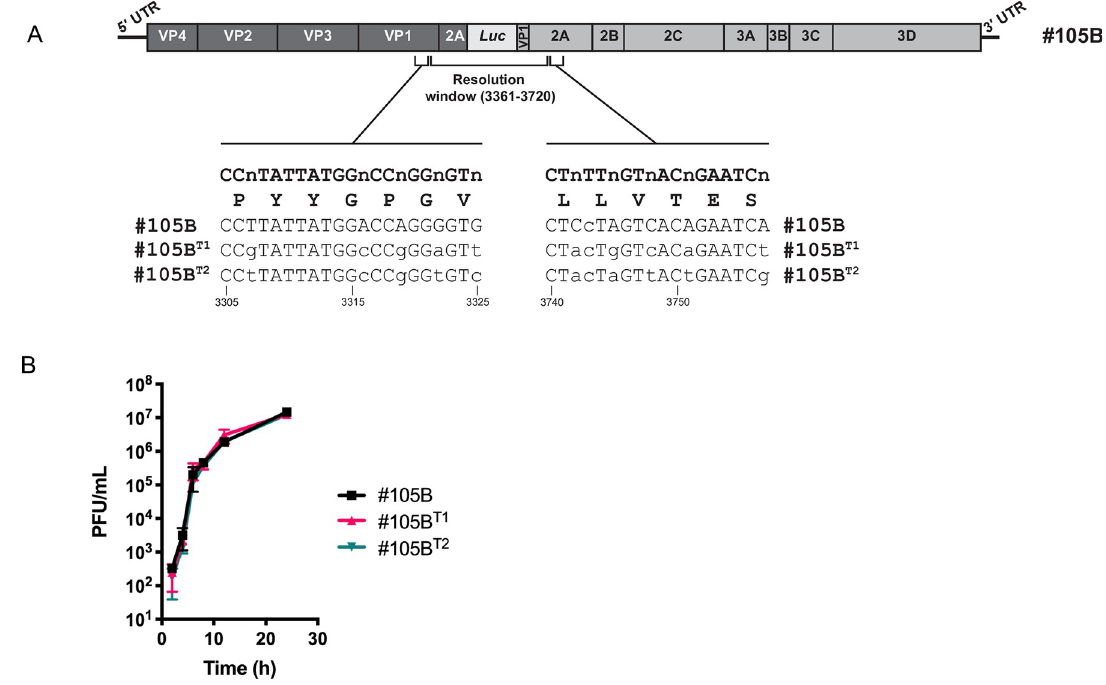
Fig 7. Characterisation of barcoded #105B. (A) Schematic representation of the sequences modified in #105B for the addition individual barcodes. (B) Replication kinetics of #105B and barcoded viruses.